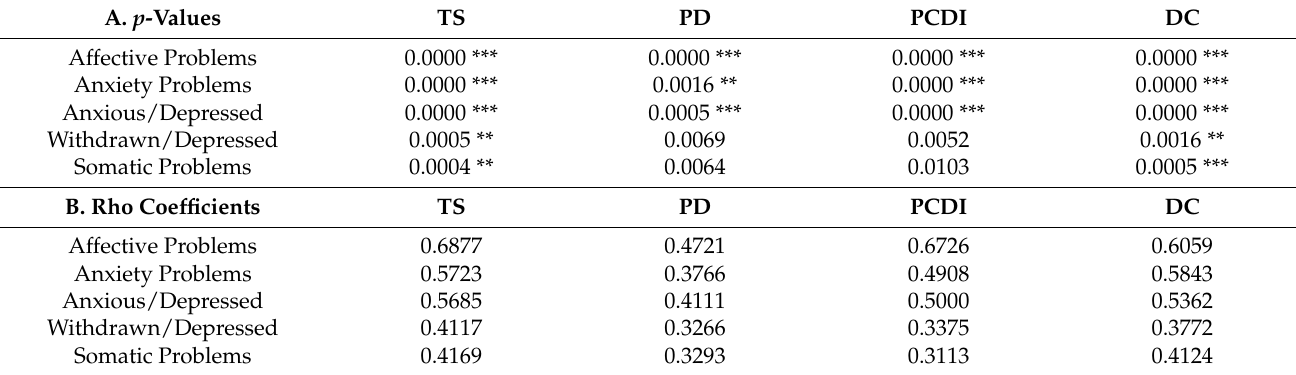
Table 2. Spearman’s rank correlations: CBCL internalizing problems subscales and PSI-4-SF subscales.